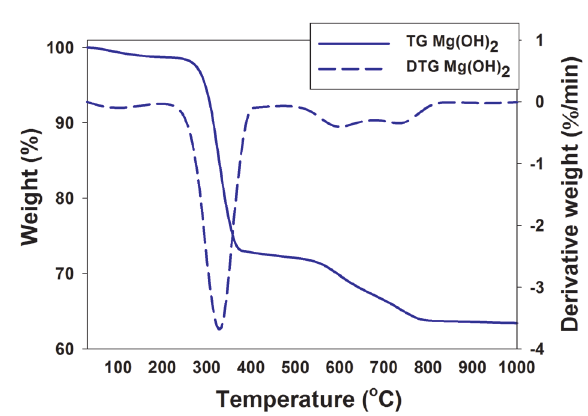
Figure 5: TG and DTG of magnesium